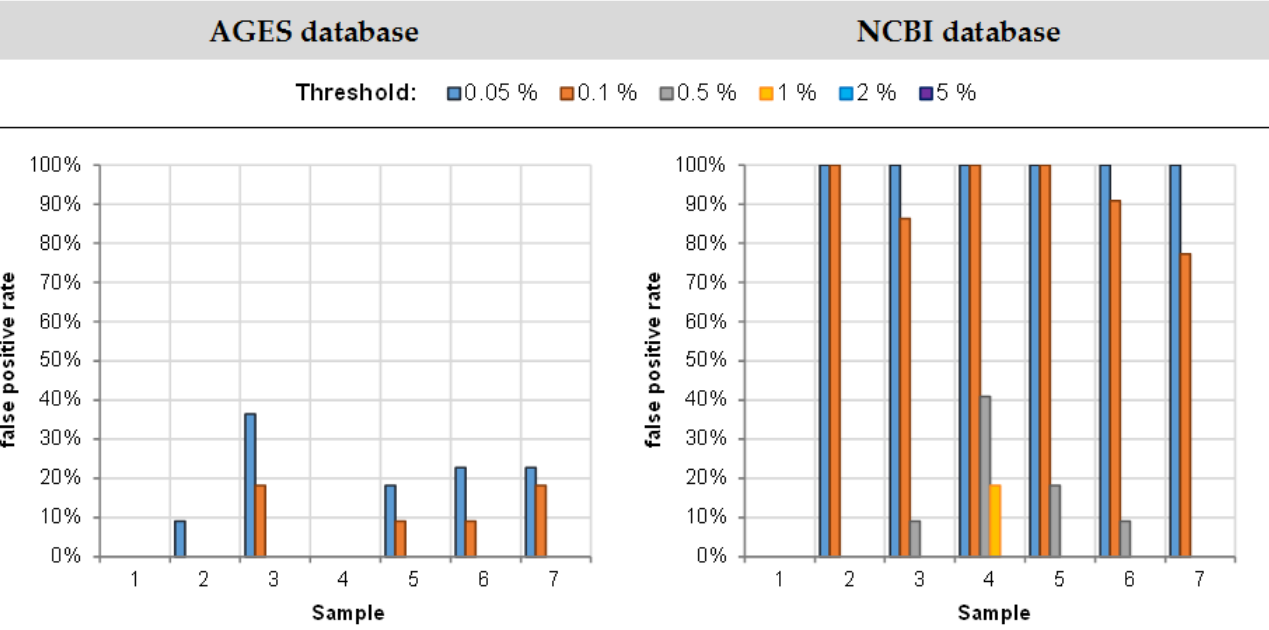
Figure 6. False positive rates by sample, depending on the defined threshold for the AGES ( left ) and the NCBI ( right ) database.